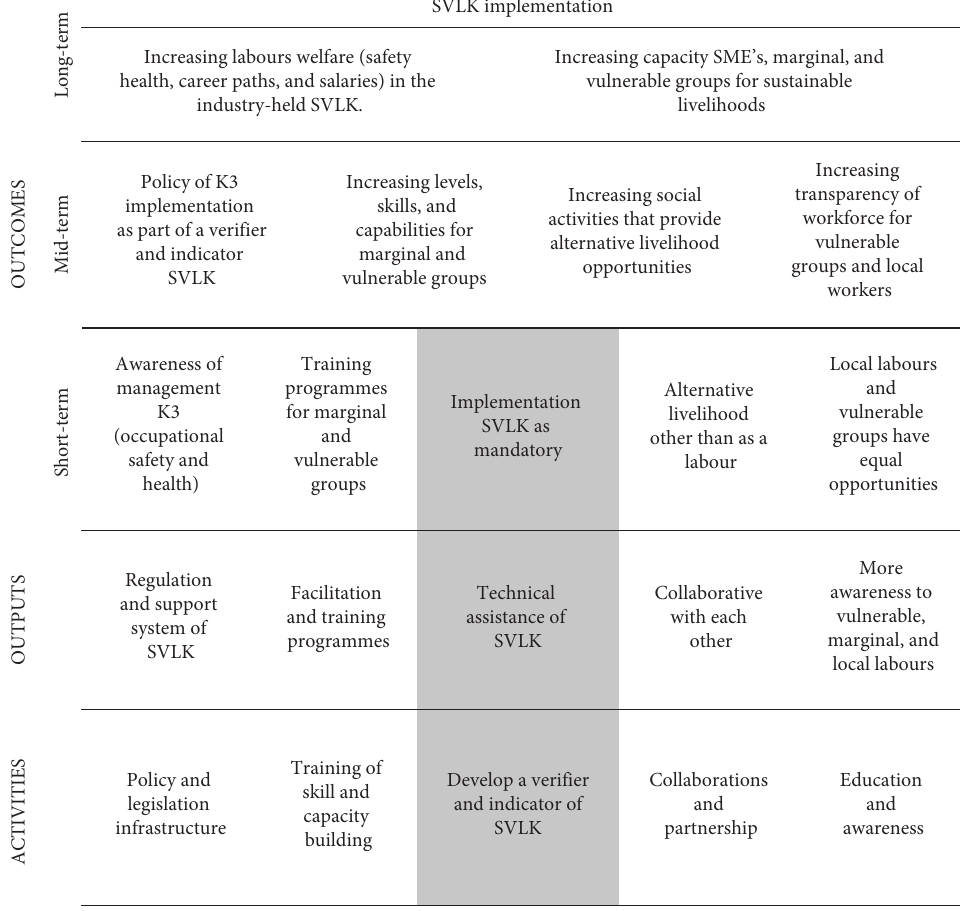
Figure 1: A logical model impact of a change of SVLK